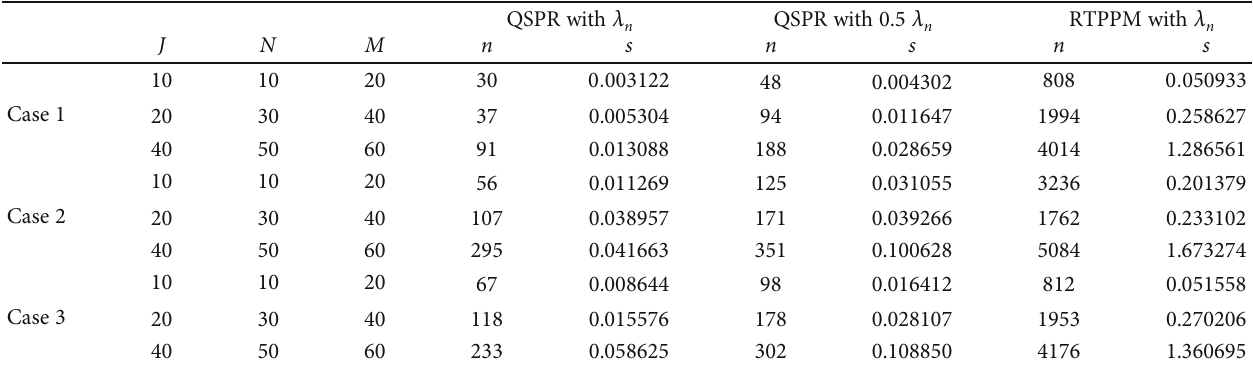
Table 3: The numerical results of Example 10.